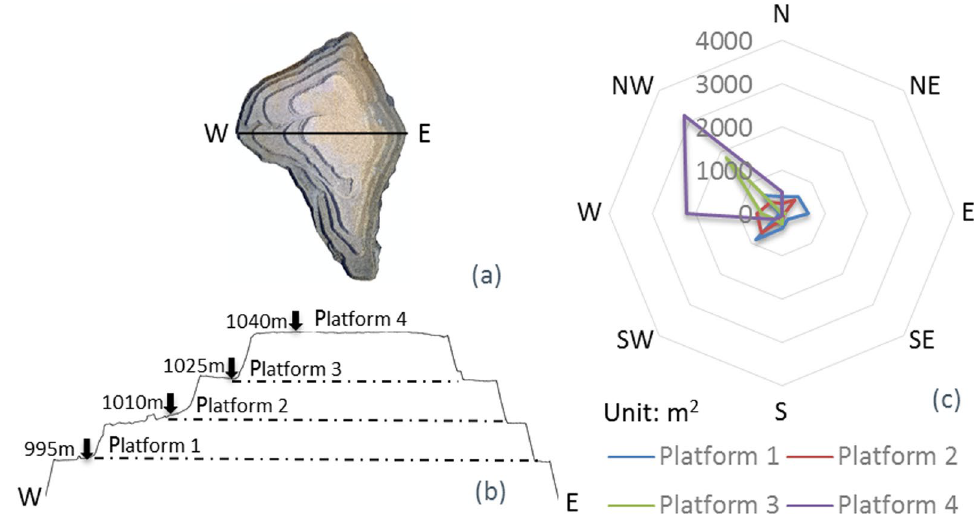
Fig. 10 Erosion gullies radar chart. a Section line; b Transverse section; c Radar chart of erosion extent of each platform. The distance from the center represents the erosion